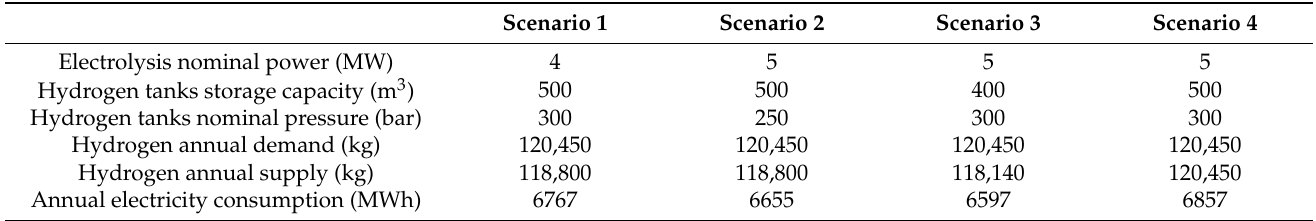
Table 4. Summary of results from the iterative calculation process of the hydrogen production and storage plant.